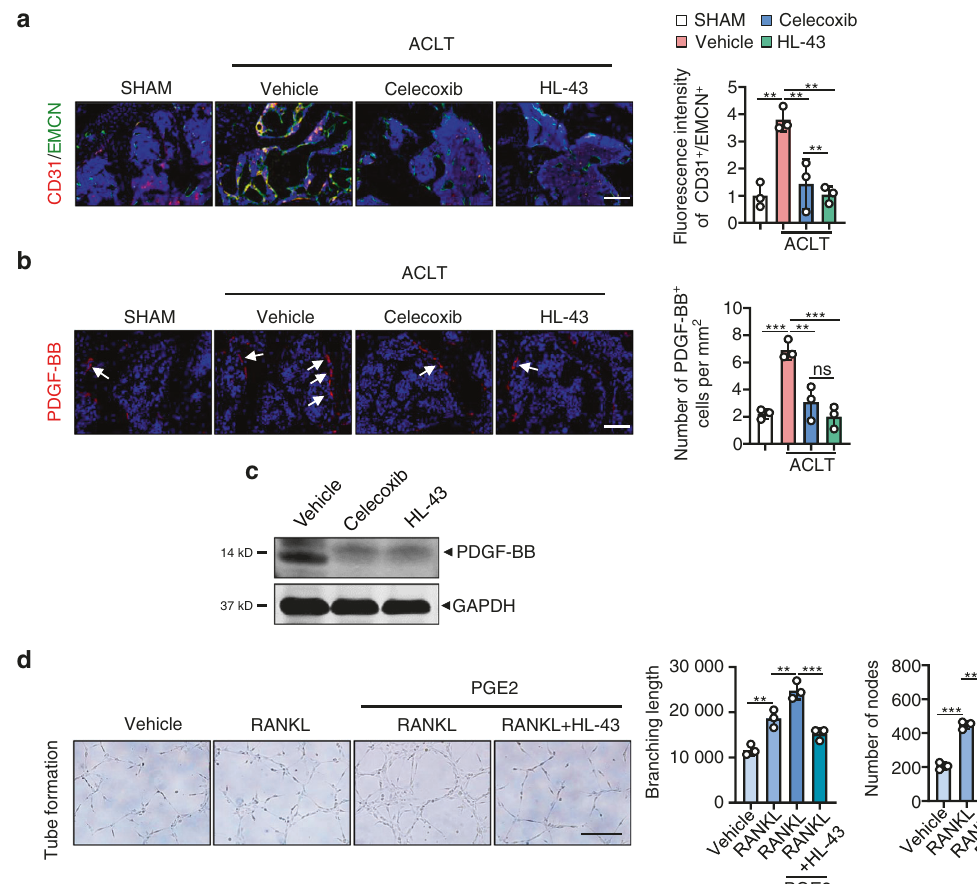
Fig. 7 HL-43 reduces type H blood vessels in subchondral bone via inhibition of PDGF-BB secretion by osteoclasts. Representative images for IHF staining of a EMCN (green) and CD31 (red) type H vessels and b PDGF-BB (red) in subchondral bone of the WT mice orally treated with celecoxib (30 mg·kg − 1 ) or HL-43 (30 mg·kg − 1 ) 2 weeks post-ACLT surgery (left) and quantitative analysis (right). The white arrows indicate PDGF-BB IHF signals. Error bars are the mean ± s.d. * P < 0.05, ** P < 0.01 and *** P < 0.001 by one-way ANOVA followed by Tukey ’ s t tests. n = 3 for each group. Scale bars, 20 μ m. c Representative images of PDGF-BB protein expression by western blotting for osteoclasts generated using BMMs from WT mice stimulated with 10 ng·mL − 1 M-CSF and 50 ng·mL − 1 RANKL. The cells were incubated with 100 nmol·L − 1 PGE2 with or without celecoxib (10 μ mol·L − 1 ) or HL-43 (10 μ mol·L − 1 ) for 3 days. The experiments were performed with three biological replicates. d Representative images of the HUVEC tube formation assay (left). BMMs isolated from the WT mice were stimulated with either 10 ng·mL − 1 M-CSF alone or with 60 ng·mL − 1 RANKL. Other treatment conditions included BMMs stimulated with M-CSF and RANKL, 100 nmol·L − 1 PGE2, with and without HL-43 (10 μ mol·L − 1 ) for 3 days. Subsequently, conditioned medium from osteoclasts was used to treat HUVECs for 4 h. The branching length and node numbers of the HUVEC tubes were quantitated (right). Error bars are the mean ± s.d. * P < 0.05, ** P < 0.01 and *** P < 0.001 by one-way ANOVA followed by Tukey ’ s t tests. n = 3 for each group. Scale bars, 50 μ The migration of osteoclast precursors to the site of bone remodeling and differentiation into multinucleated osteoclasts are the keys to osteoclast function. Here, using genetic deletion, we show that PGE2 acting via the EP2 and EP4 receptors can regulate migration and osteoclast differentiation, consistent with a previous fi nding by Kobayashi et al., which describes enhanced osteoclast differentiation from RAW264.7 cells following PGE2 exposure and suggests EP2 and EP4 as the likely mediators 69 . Interestingly, in our in vivo model of OA, mice with EP4 deletion in the myeloid (osteoclast precursor cells) showed a marked improvement in most parameters measured to assess OA progres- sion, including subchondral bone microarchitecture and osteo- phyte formation. However, deletion of EP2 had little effect on improving OA progression in this model. Additionally, EP2 deletion failed to elicit any reduction in articular cartilage degeneration or OA progression in the DMM-induced OA model (data not shown). These data suggested that EP2 might have little effect on the progression of murine OA. While EP2 is known to be highly expressed in articular cartilage 47 , its role in OA remains unclear. EP2